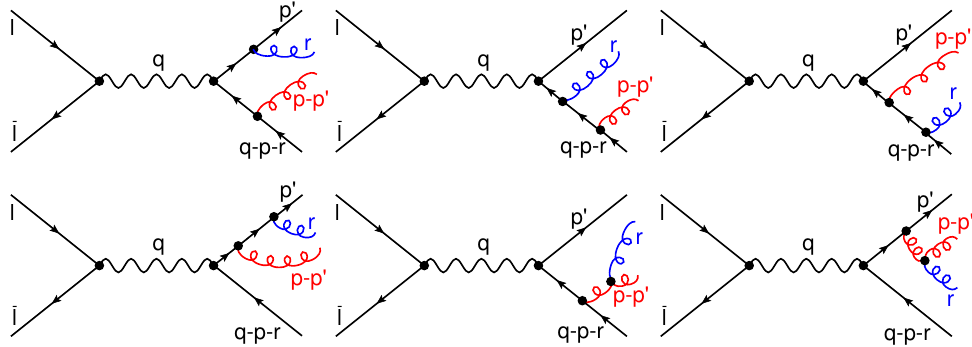
Figure 8. NLO corrections from real gluon radiation to quark-gluon